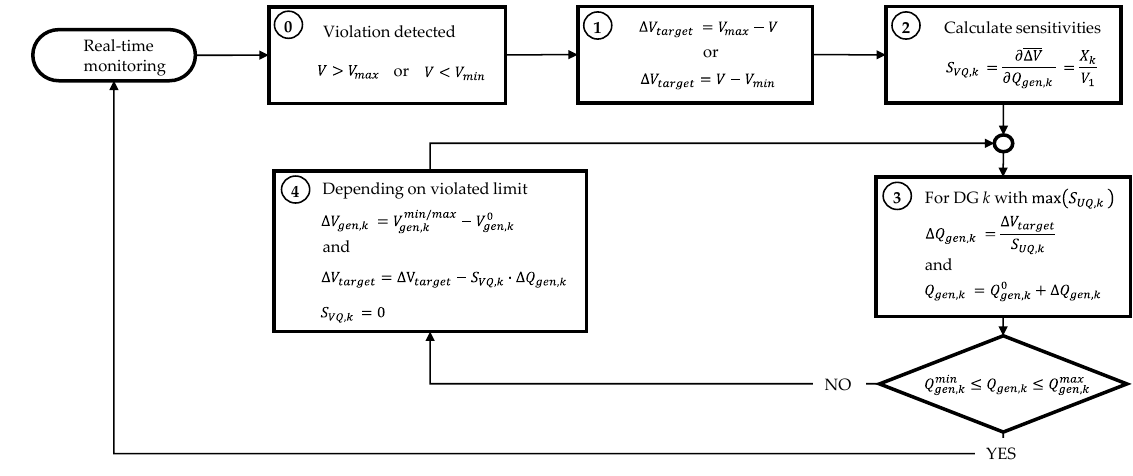
Figure 5. Coordinated Control strategy flowchart.